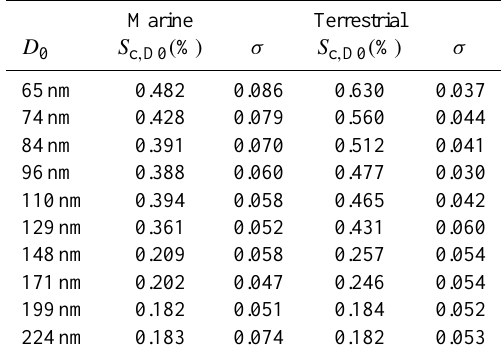
Table 1. A table of mean critical supersaturation, S c , D0 , for each measured dry diameter, D 0 , for the Marine and Terrestrial periods of OP3-III, with standard deviation, σ